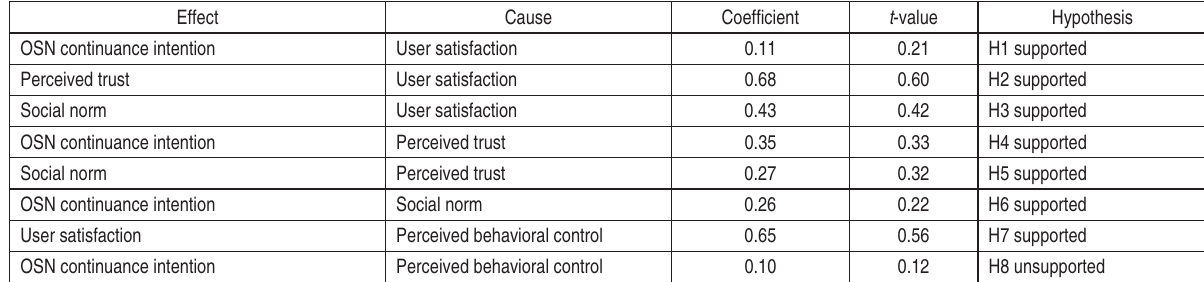
Table 5. Summary of the result of hypothesis